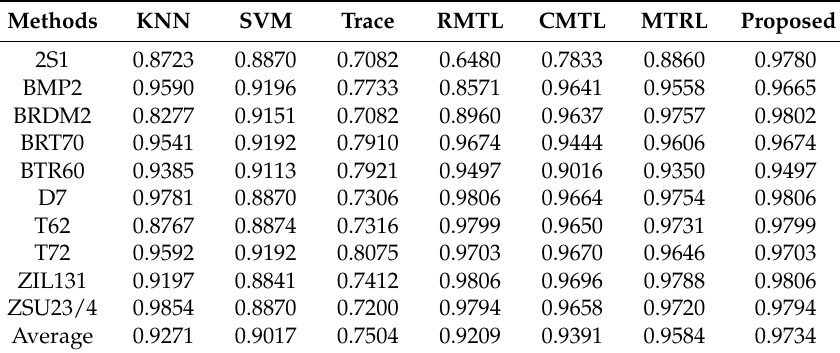
Figure 10. Recogniton rates of ten vehicles versus different methods. Table 5. Recogniton rates of all the compared methods under SOC.